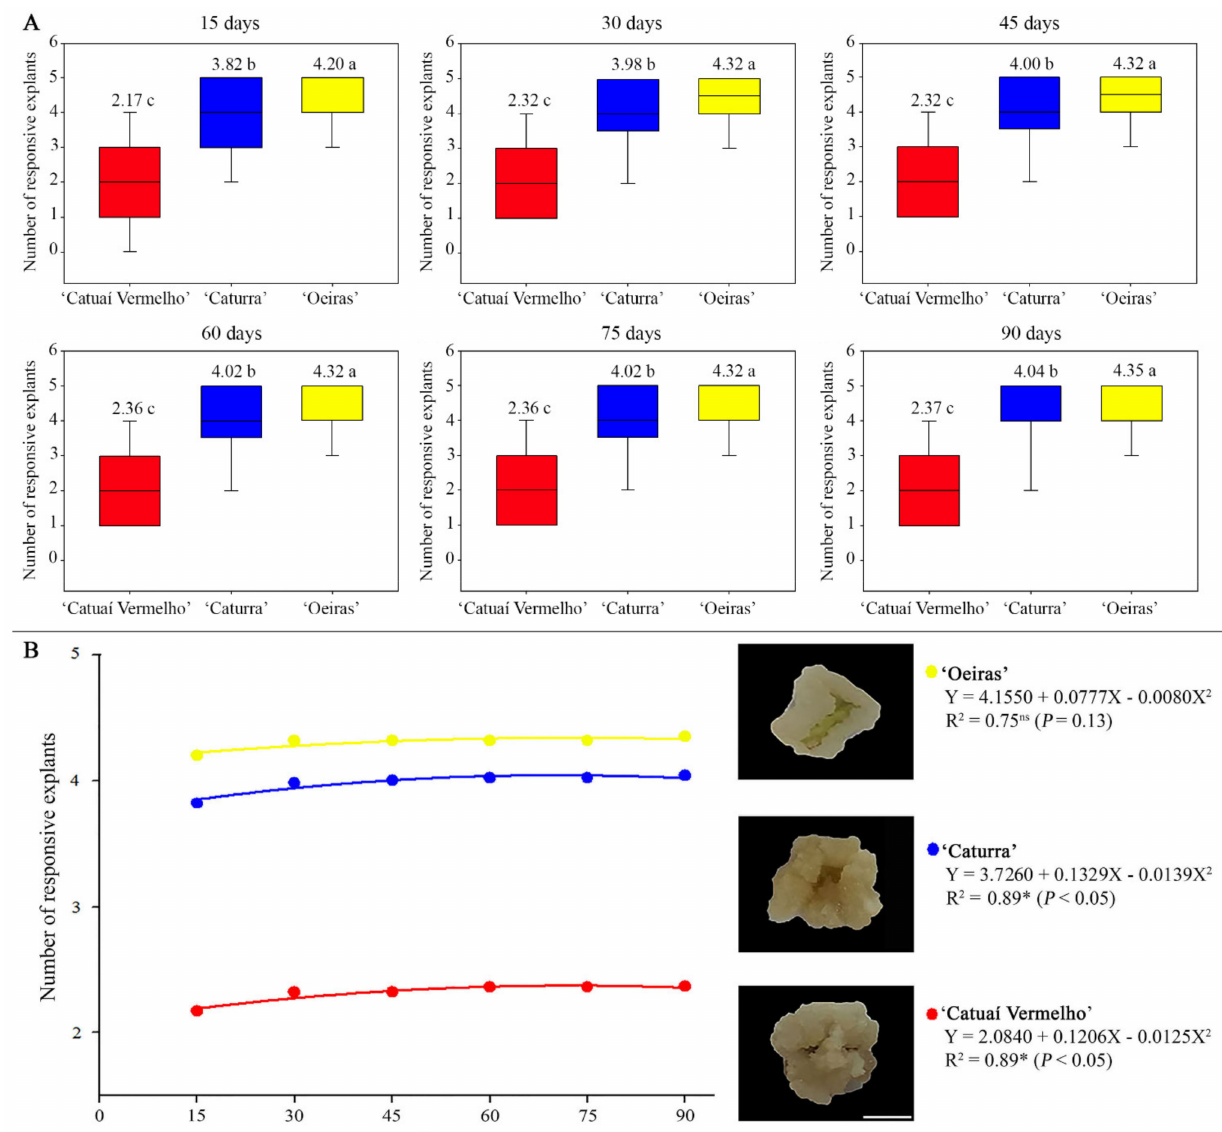
Figure 1. Mean number of responsive explants of ‘Catua í Vermelho’, ‘Caturra’ and ‘Oeiras’ in callus induction and proliferation medium over 90 days. ( A ) The C. arabica lines exhibited distinct values of responsive explants over 90 days. ( B ) The adjusted model was significant ( p < 0.05) by the quadratic polynomial regression for ‘Catua í Vermelho’. All calli exhibited a pale-yellow color and friable appearance. Mean values followed by the same letter do not present a significant difference. Bar = 2